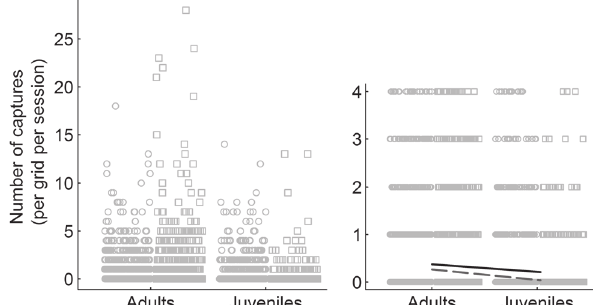
Figure 7. Graphical representation of the interactions between trap type (pitfall traps: circles; Sherman traps: squares) and age in de- termining the number of captures. Overlapping dots are horizon- tally scattered to improve visualization. On the left, the whole dataset is shown; on the right, a zoom for better visualization of the lines that show the expected means for each trap type and age estimated from the best model in Table 3 (solid line: pitfall traps; dashed line: Sherman traps).